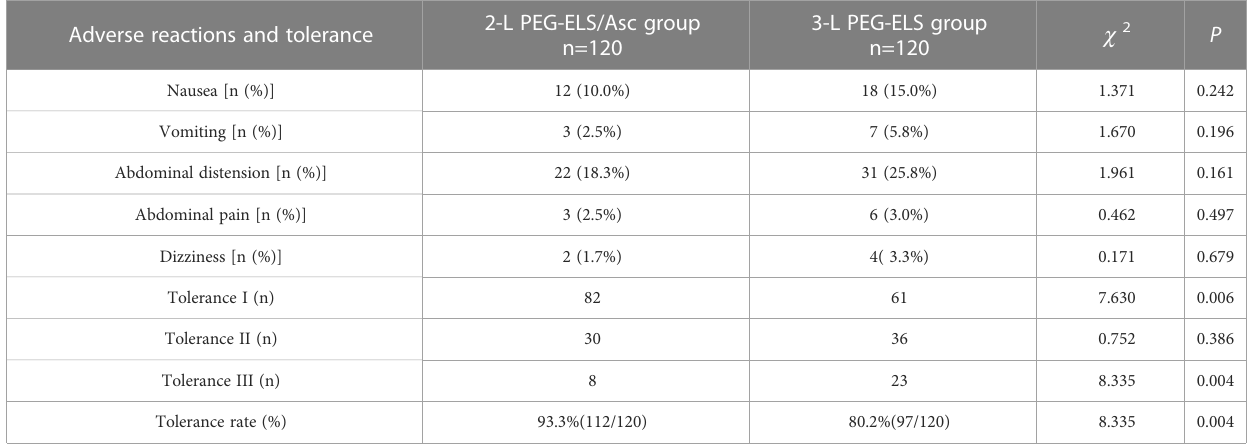
TABLE 6 Comparison of adverse reactions and tolerance between the two groups. Adverse reactions and tolerance